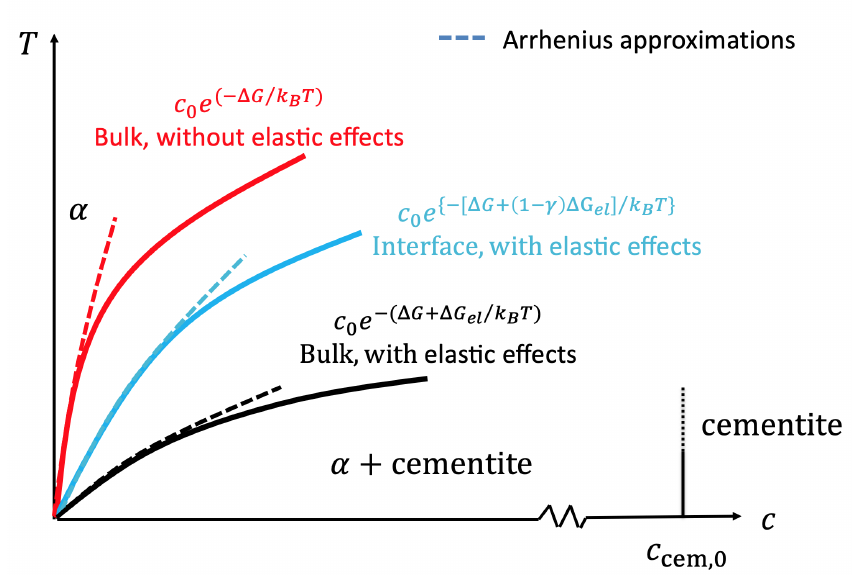
Figure 3. Sketch of the investigated phase diagram with the coexistence of a solid solution α phase with a “cementite” phase. The (artificial) neglect of elastic effects leads to a bulk solubility limit, which is marked by the solid red curve. For low temperatures, it is well described by the (dashed, red) Arrhenius approximation, Equation (2). Additional inclusion of elastic effects shifts the curves to the right (corresponding to γ = 0 in Equation (3) for the Arrhenius asymptotics); hence, the solubility limit is increased (black curve pair). From there, the proximity to a free surface decreases 1 − γ and therefore leads to the blue curves for the solubility limit, which is in between the bulk cases with and without elasticity (blue curves). For an explicit example, we mention shear-coupled grain boundary motion in Fe-C with phase coexistence between ferrite ( α ) and cementite Fe 3 C, for which c cem,0 = 6.67 wt%. The carbon solubility in ferrite is very low; hence, the description as a dilute alloy is appropriate. According to Equations (3) and (7), the reduction of the solubility limit for carbon near a shear-coupled grain boundary in ferrite is approximately 50% (blue curves) relative to the bulk elastic situation (black curves) for an array of precipitates at room temperature, as discussed in detail in